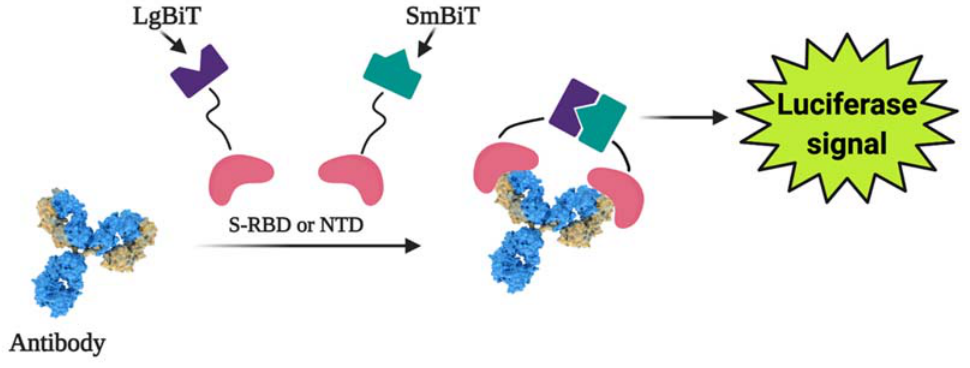
Figure 4. The general working concept of a split luciferase ‐ based biosensor. Figure from [22]. Considering SARS ‐ CoV ‐ 2 carriers have antibodies directed predominantly